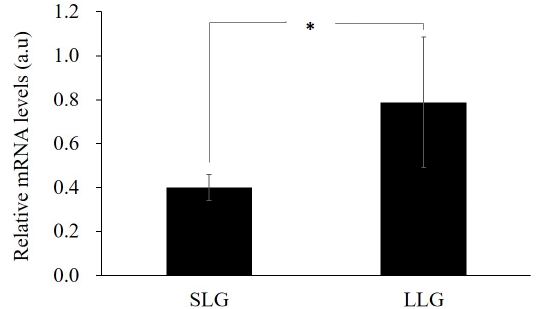
Figure 4. The effect on gene expression of promoter hypomethy- lated ZPBP in uterine tissues by RT-PCR. The bars represent the mean ± SD; n = 3. ∗ Significantly different between both groups at p < 0 . 05. SLG: smaller litter size group; LLG: larger litter size